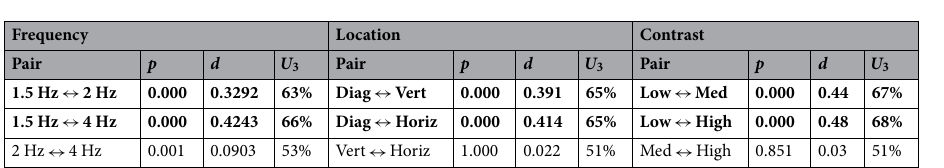
Table 1. P values of the t test between pair of conditions (without compensation for multiple comparisons) and d -Cohen, U 3 -Cohen of ES for location, frequency, and contrast setups. Statistical significant results (for the t test and ES both) are in bold.